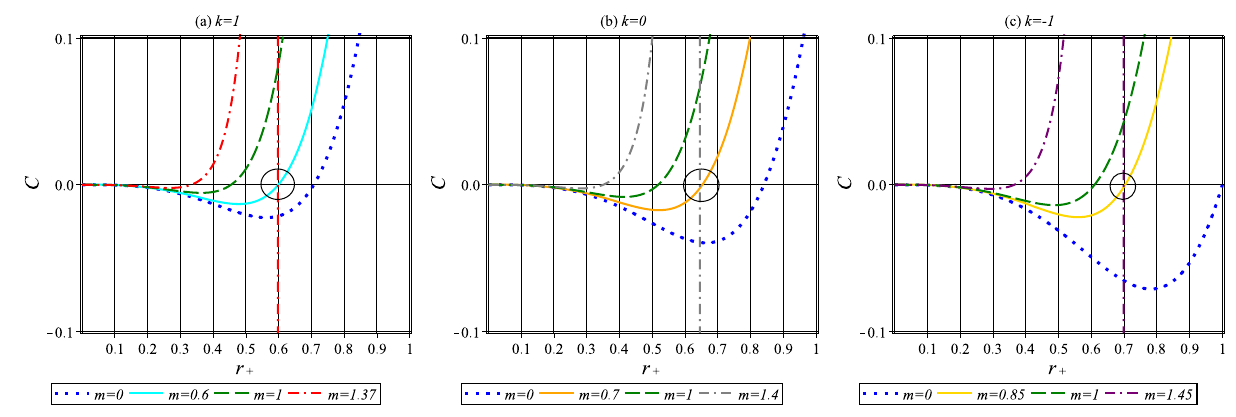
Fig. 7 Specific heat of the second model (Eq. (3.18)) in terms of r + , with unit values for the model parameters Fig. 8 Typical behavior of the entropy in the third model (Eq. (3.20)) for λ = 1. a in terms of r + for different values of ε , and b in terms of ε for r + = 0 .